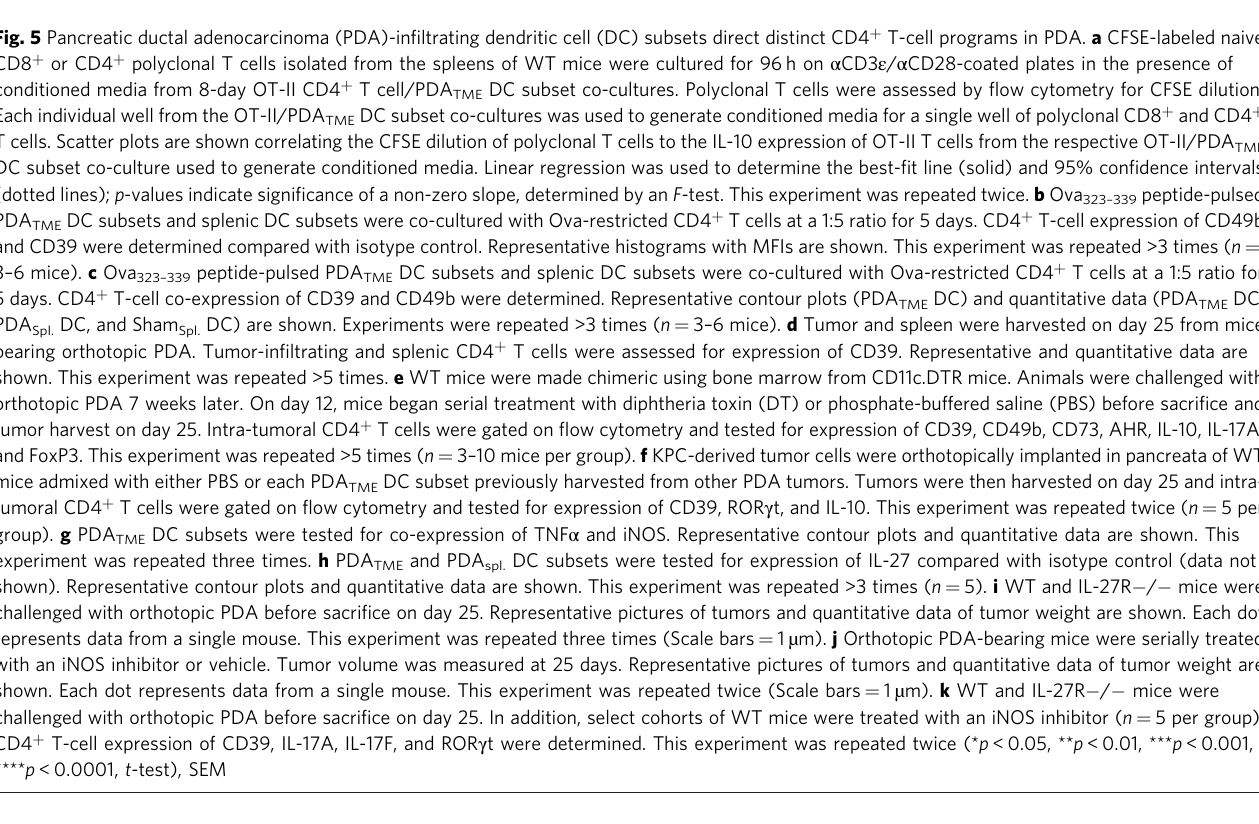
Fig. 5 Pancreatic ductal adenocarcinoma (PDA)-in fi ltrating dendritic cell (DC) subsets direct distinct CD4 + T-cell programs in PDA. a CFSE-labeled naive CD8 + or CD4 + polyclonal T cells isolated from the spleens of WT mice were cultured for 96 h on α CD3 ε / α CD28-coated plates in the presence